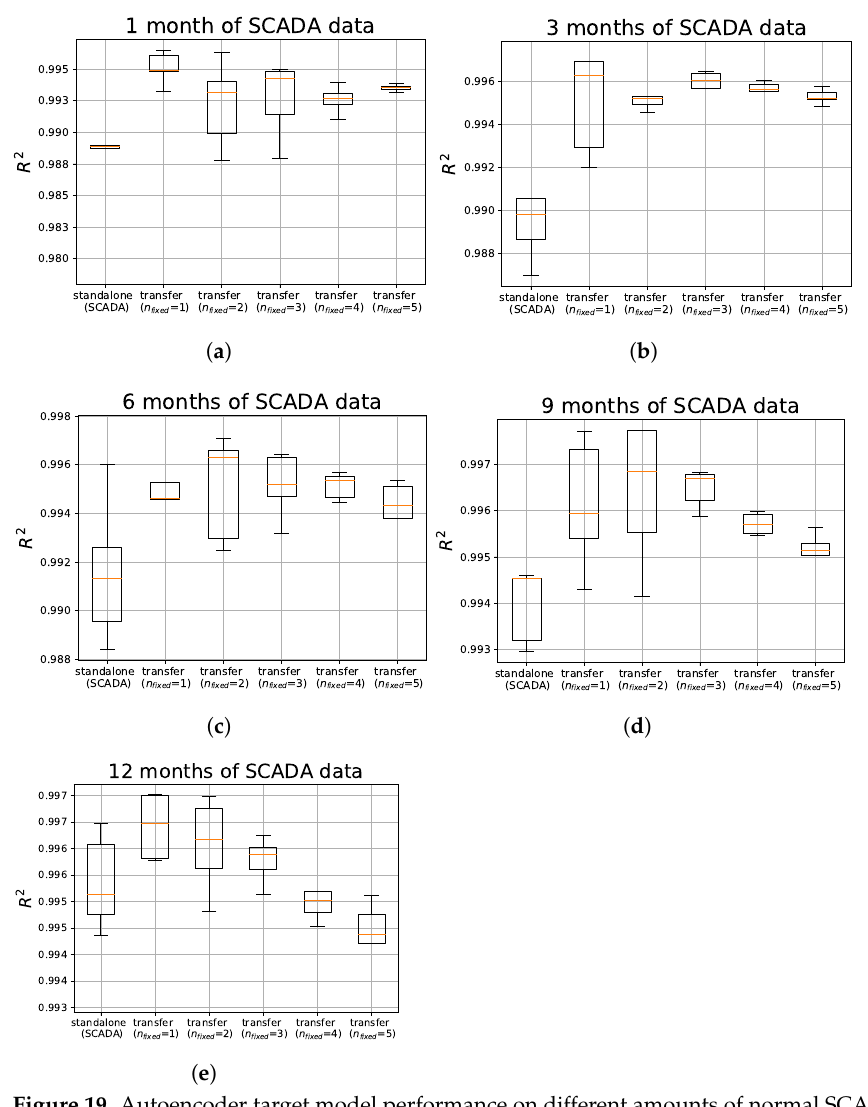
Figure 19. Autoencoder target model performance on different amounts of normal SCADA data and knowledge transfers. Each boxplot represents the R 2 distribution of the models trained within the five-fold crossvalidation. The target models are trained using 1 month ( a ), 3 months ( b ), 6 months ( c ), 9 months ( d ) and 12 months ( e ) of normal SCADA data. Table 2. Prediction performance of SDAE for different amounts of training data and knowledge